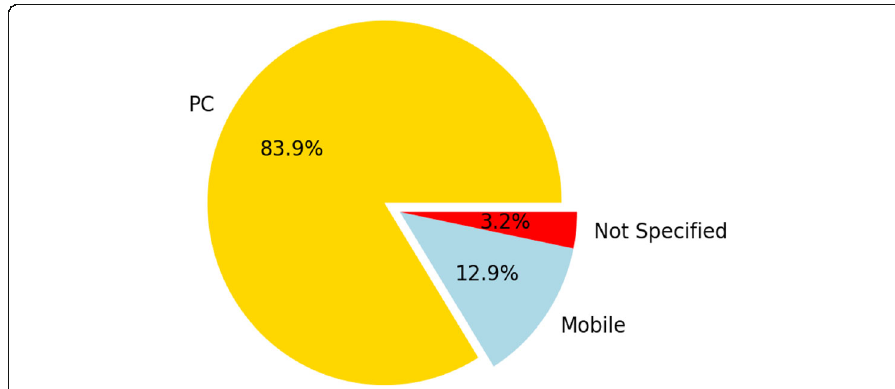
Fig. 5 The distribution of the platforms in the literature within the SR Table 6 Technological Characteristics of